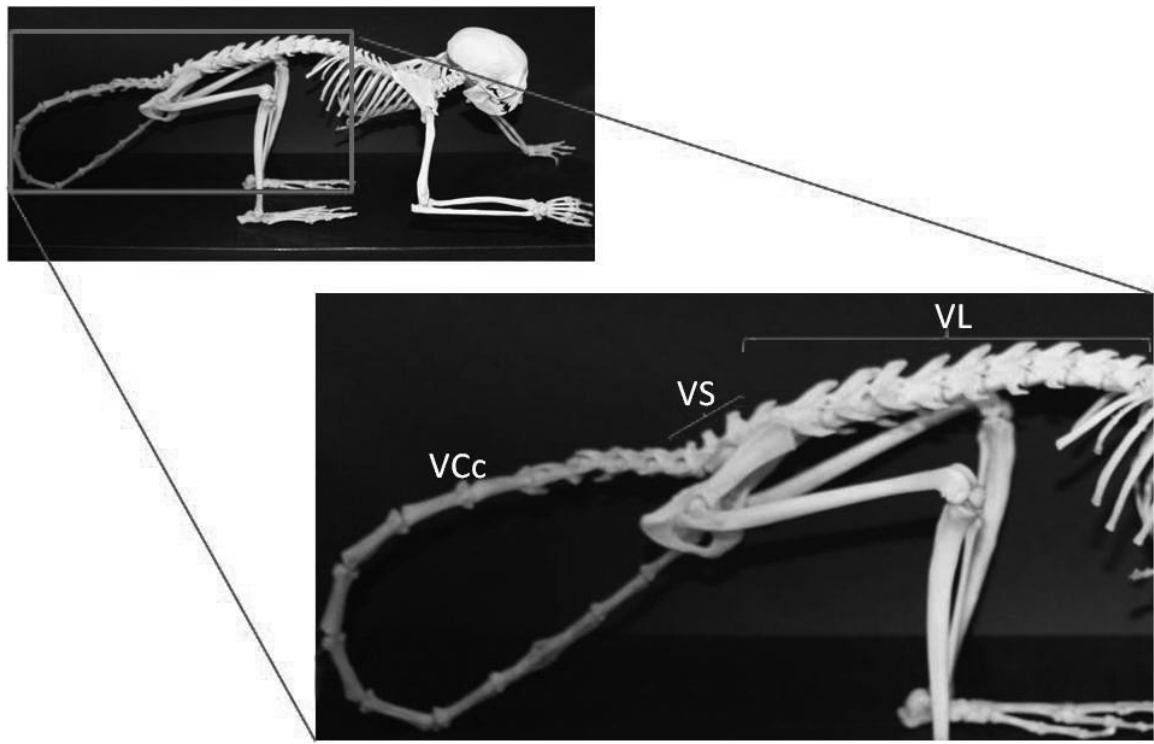
Fig. 1 – Photograph of the skeleton of Saimiri sciureus . In the detail lumbo-sacrale region of the vertebral column show the vertebrae lumbales (VL), vertebrae sacrales (VS) and vertebrae coccygeae (VCc).